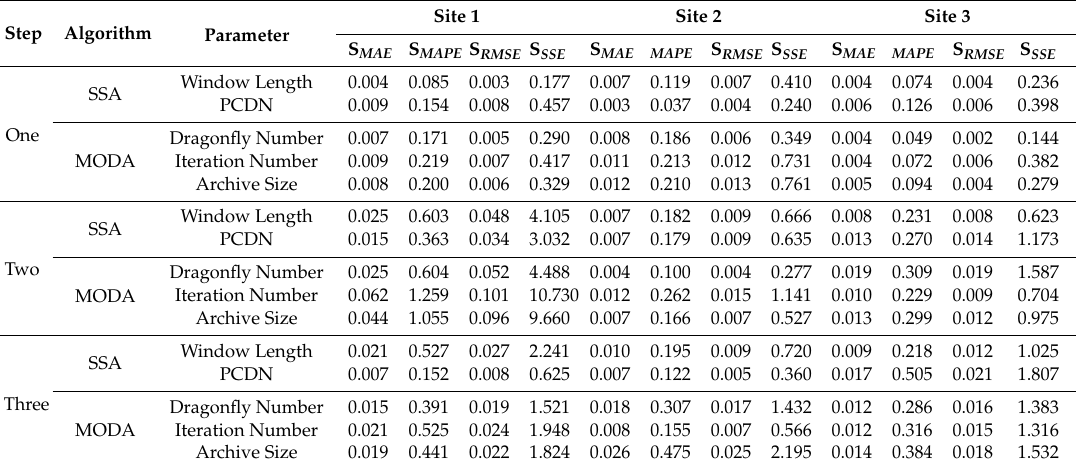
Table 12. Results of sensitivity indicators obtained from SSA and